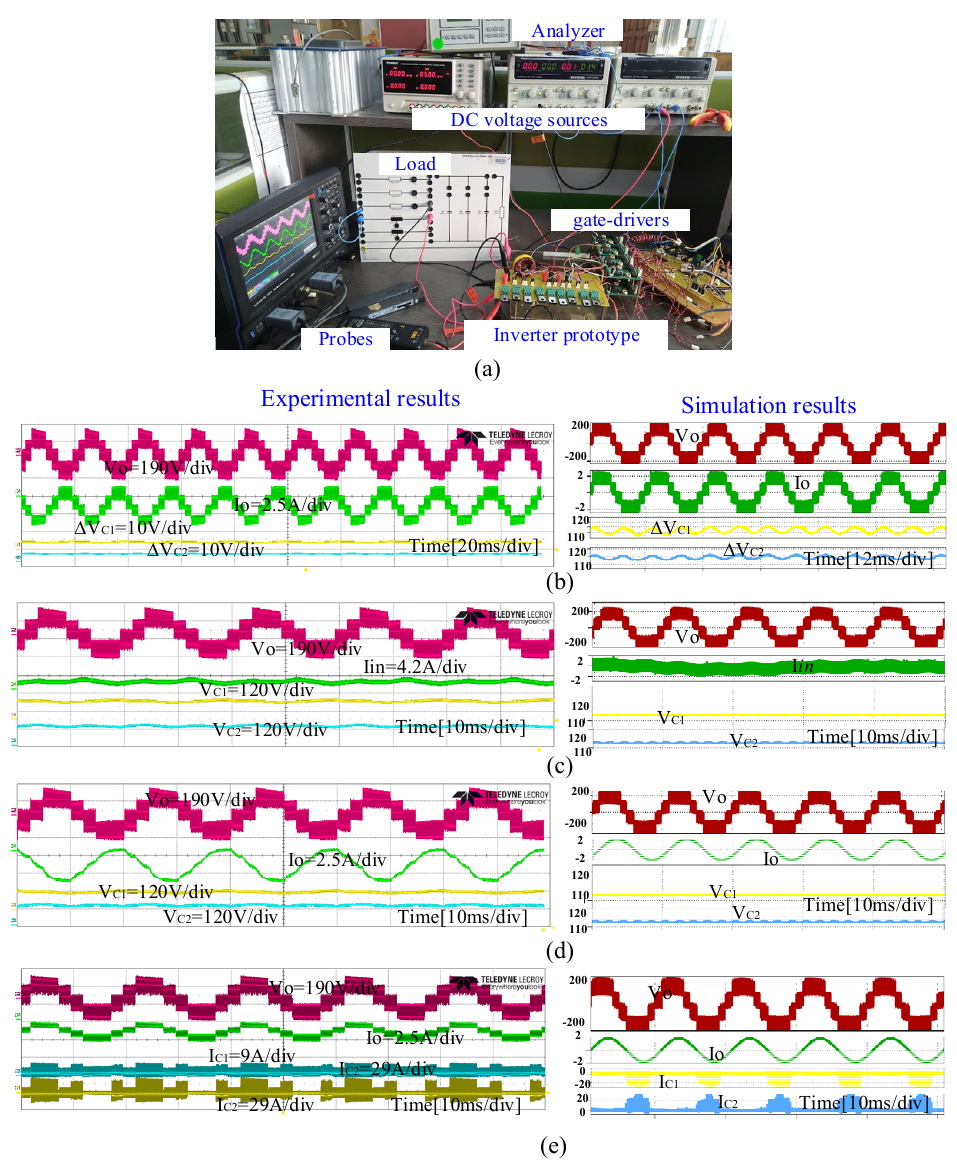
Figure 3. ( a ) Experimental setup, and steady-state experimental and simulation results for R-load (R = 100); ( b ) C 1 and C 2 voltage ripple; ( c ) input current and capacitors’ voltage ripple, and ( R = 100 Ω ); ( b ) C 1 and C 2 voltage ripple; ( c ) input current and capacitors’ voltage ripple, and steady-state results for RL-load ( R = 100 Ω , L = 200 mH); ( d ) C 1 and C 2 voltage; ( e ) C 1 and C 2 charg- steady-state results for RL-load ( R = 100 Ω , L = 200 mH); ( d ) C 1 and C 2 voltage; ( e ) C 1 and C 2 ing current. charging